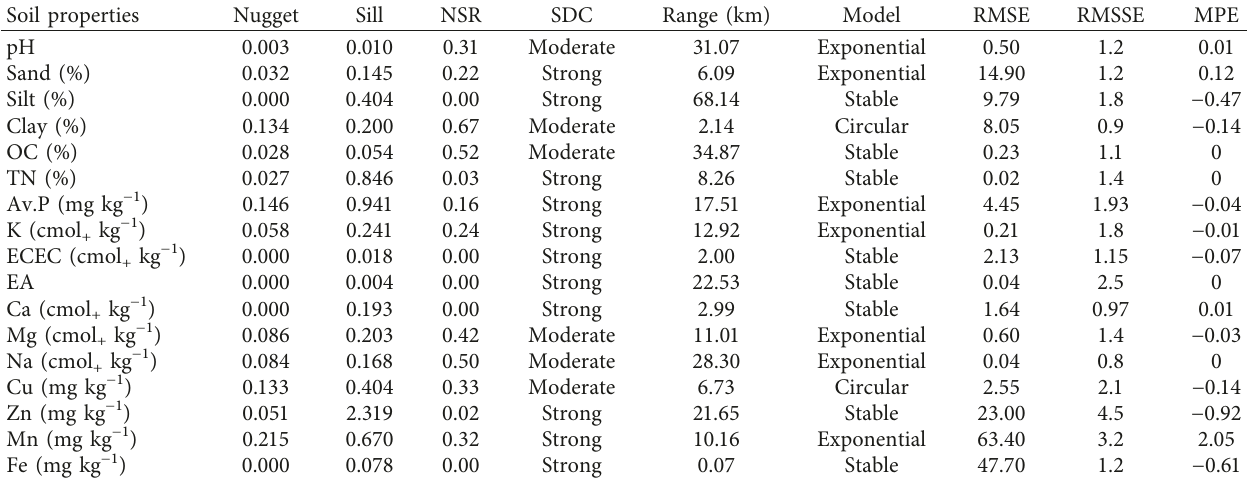
Table 3: Best-fitted semivariogram model parameters of soil variables of the study location.